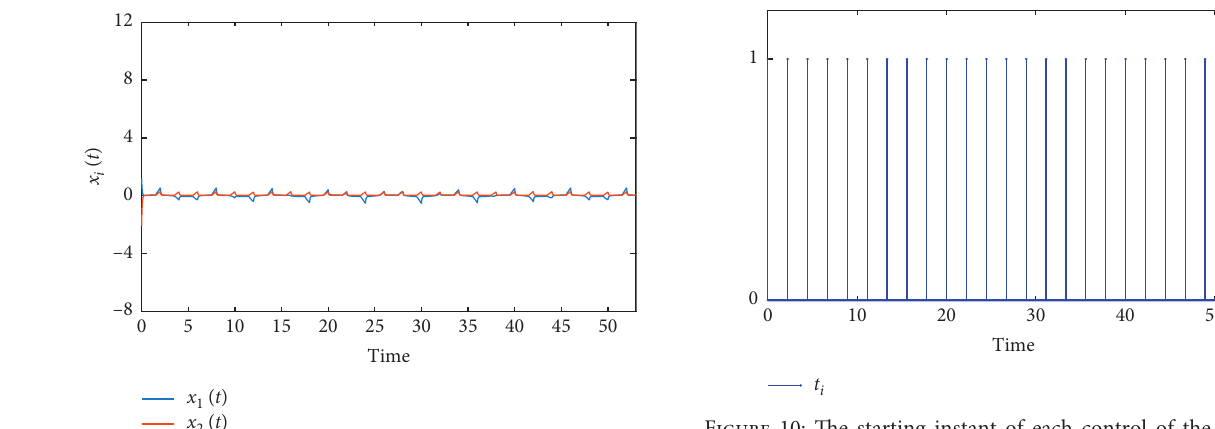
( i � 1 , 2 ) of system (112) under the i